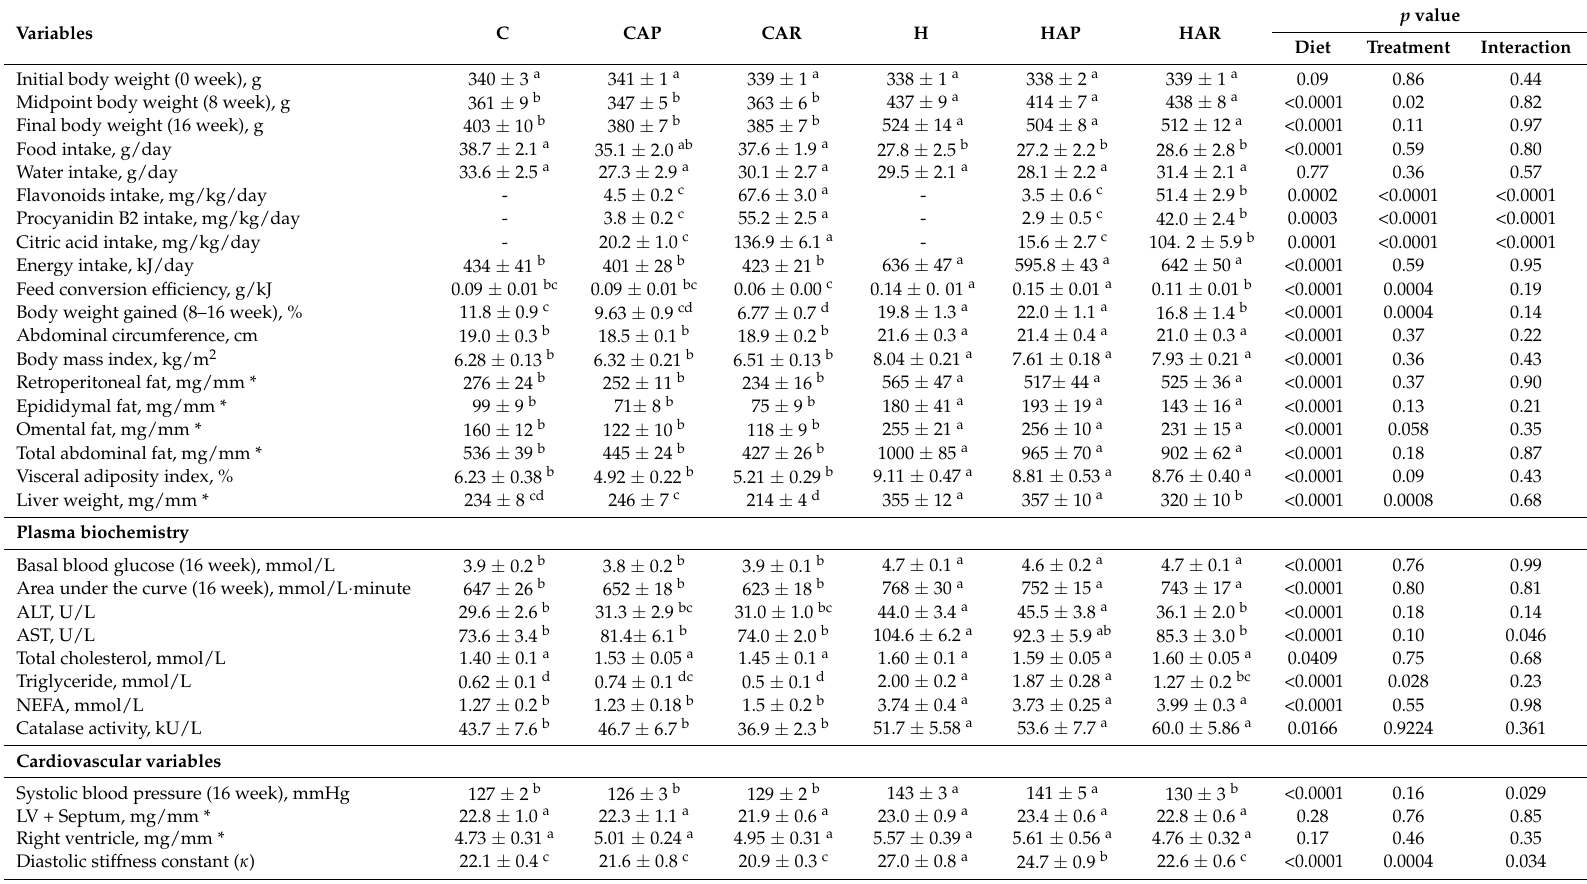
Table 1. Effects of G. humilis on abdominal fat content, metabolic, and physiological